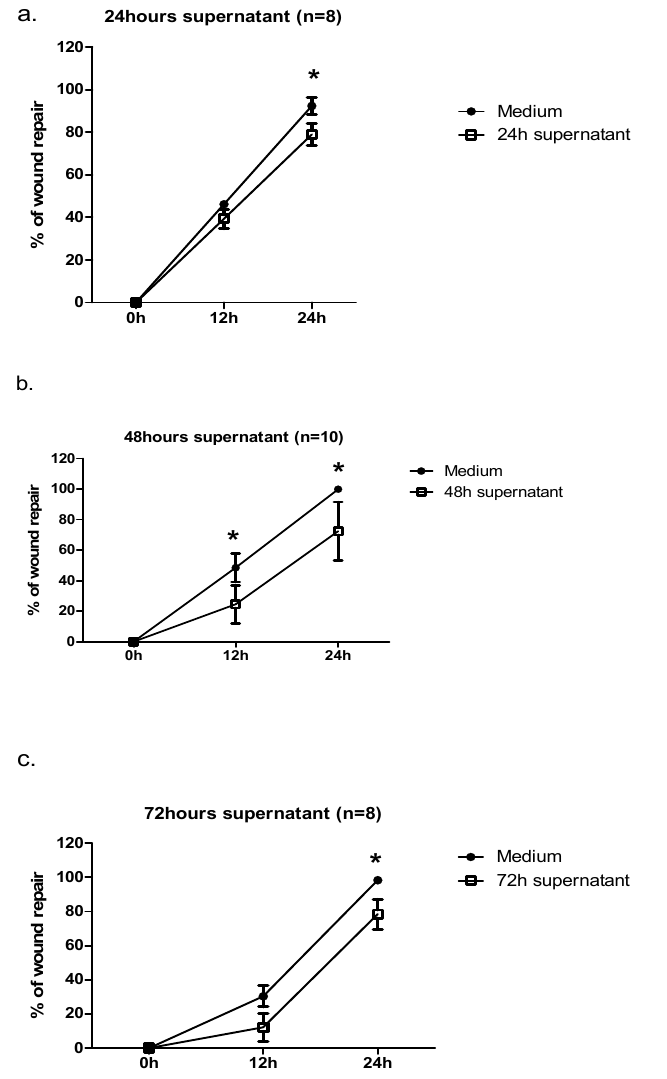
Figure 5. Effect of supernatant from RV1b-infected epithelial cells on wound repair. ( a ) 24 h supernatant; ( b ) 48 h supernatant; ( c ) 72 h supernatant; * p < 0.05.